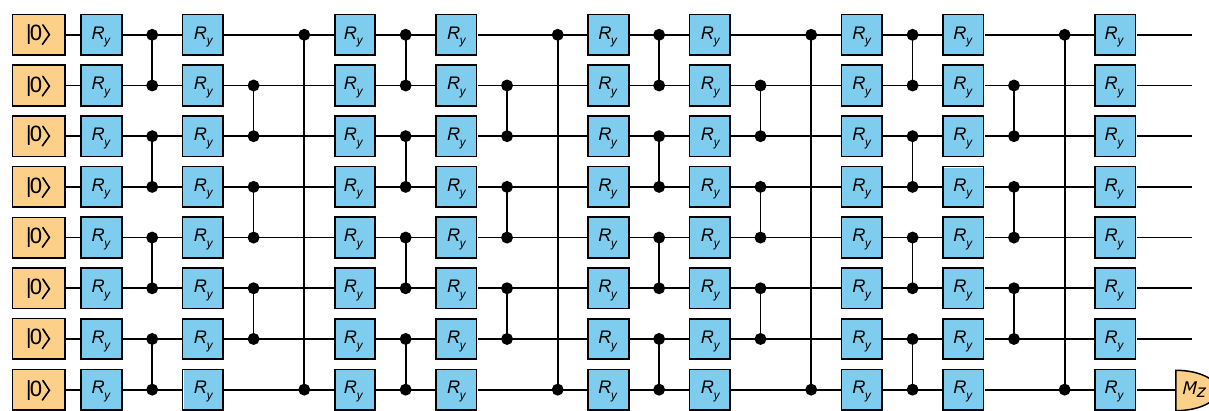
FIG. 18. Qubits follow the cycle graph pattern with the first qubit being adjacent to the last one. Gates are implemented from bottom up if they are on the same vertical line. Black two-qubit gates are control- Z gates and single qubit R y gates are rotations around the y axis of the Bloch sphere. Here M z denotes a single-qubit measurement along the z axis of the Bloch sphere.